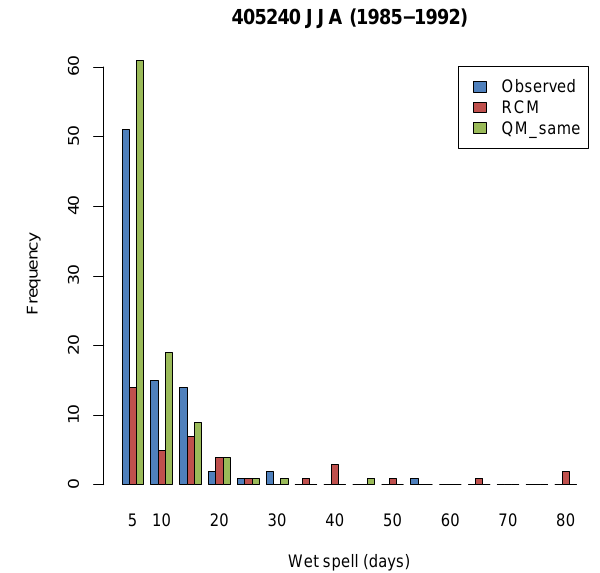
Figure 12. Histograms of consecutive wet days for observed, raw RCM and QM bias-corrected RCM precipitation for one study